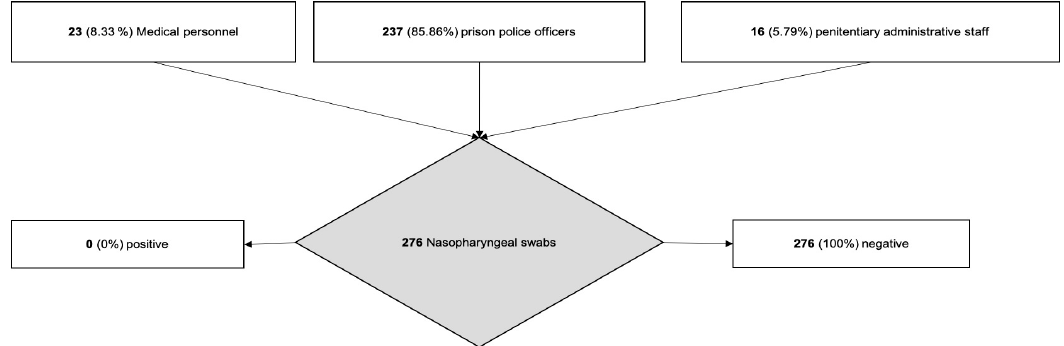
Figure 3. Flowchart of the prison personnel’s COVID screening.